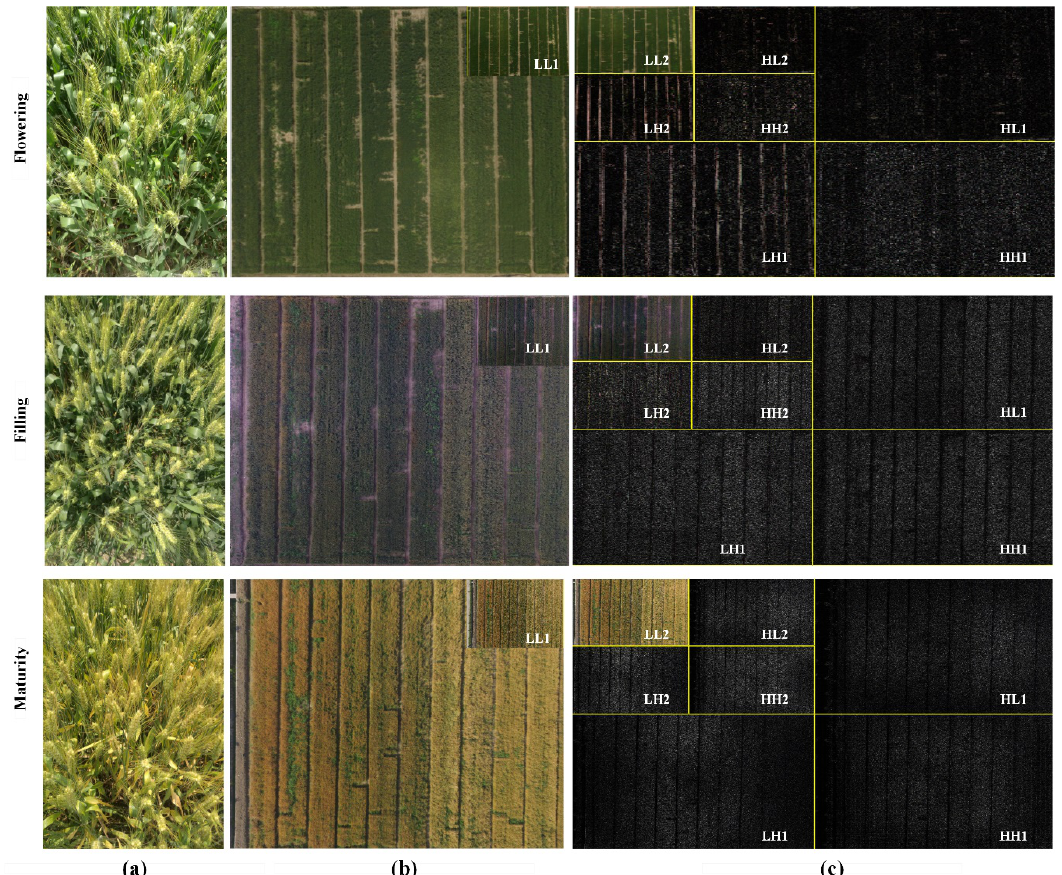
Figure 4. Two-layer wavelet decomposition based on images obtained by an unmanned aerial vehicle (UAV). ( a ) Canopy photos, ( b ) the original image and the low-frequency LL1 subgraph, and ( c ) a tower structure diagram of wavelet decomposition.